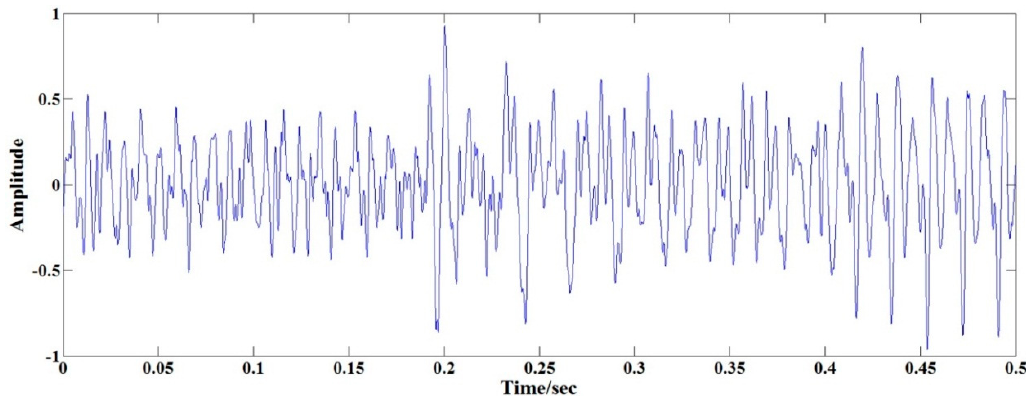
Figure 6. The extracted sound signal of the motor.